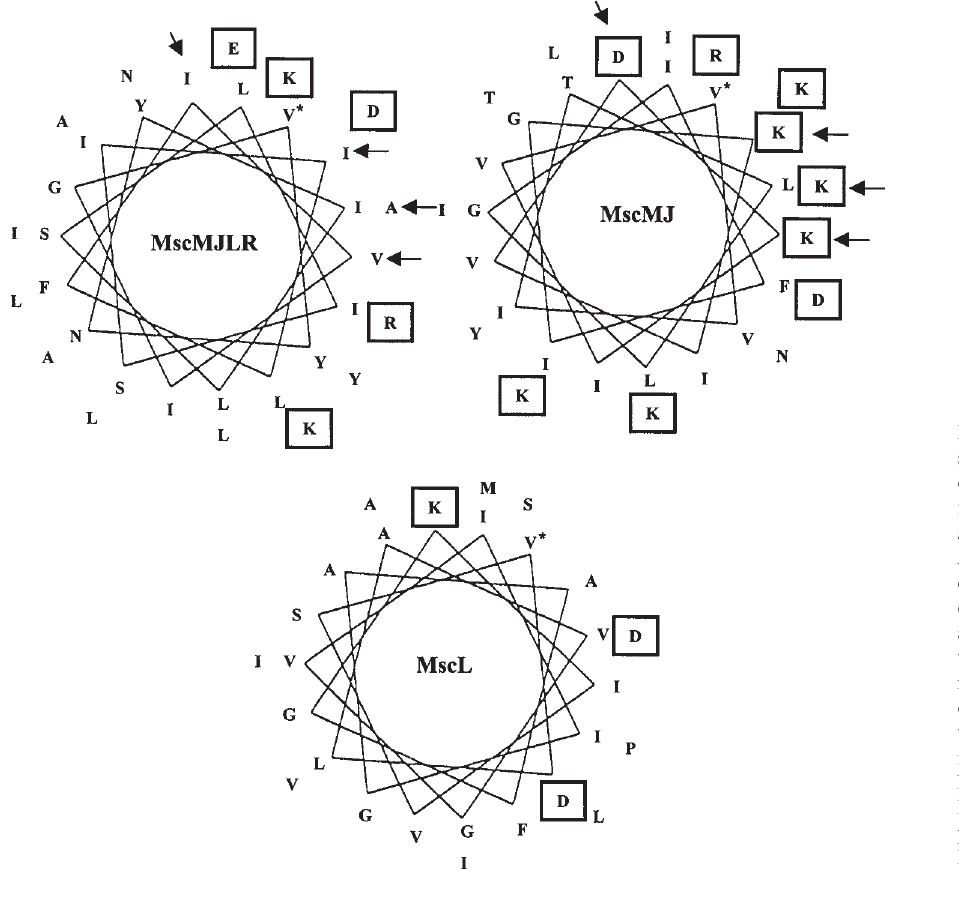
Figure 7. Helical wheel repre- sentation of the TM1 domains of MscMJLR and MscMJ from Methanococcus jan- naschii and of MscL from Escherichia coli . Charged resi- dues are boxed and the start of each helix is marked with an asterisk. Arrows indicate posi- tions at which hydrophobic residues within the TM1 helix of MscMJLR are replaced with hydrophilic (charged) res- idues in the MscMJ helix. Note that the TM1 domains of MscMJ and MscMJLR are hy- pothetical. Adapted from Kloda and Martinac (2001 b